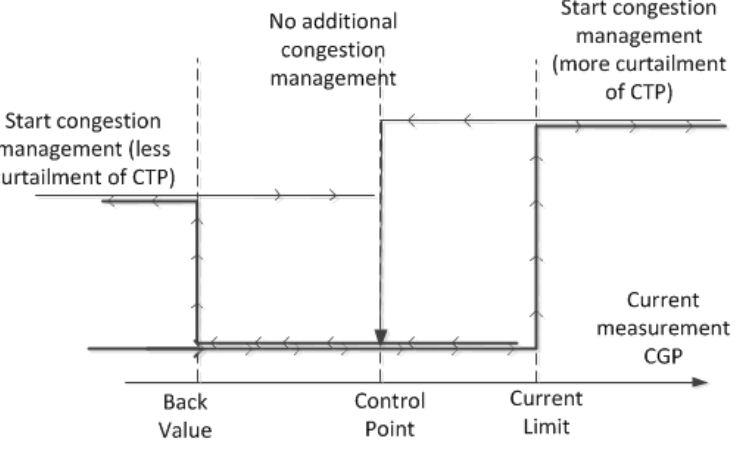
Figure 3. Congestion management initiator